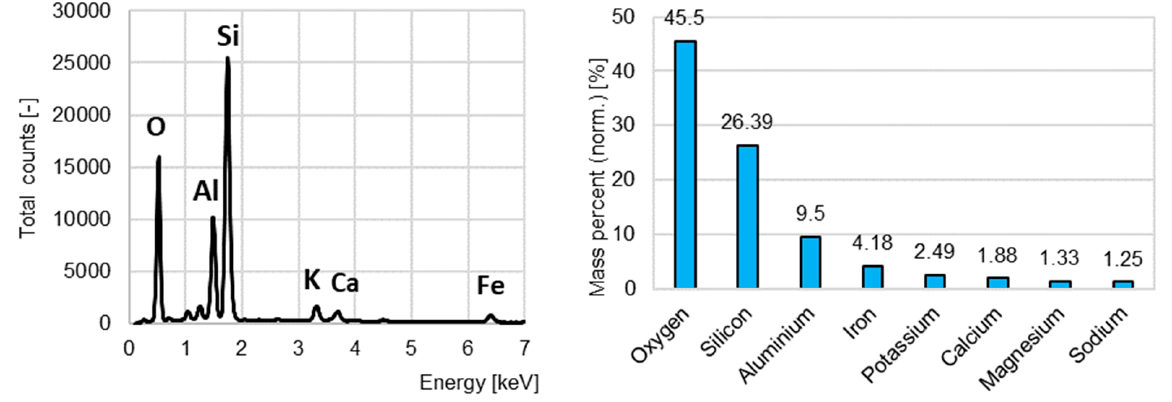
Figure 5. The energy-dispersive X-ray spectroscopy results for the ceramic brick recycling aggre- gate.